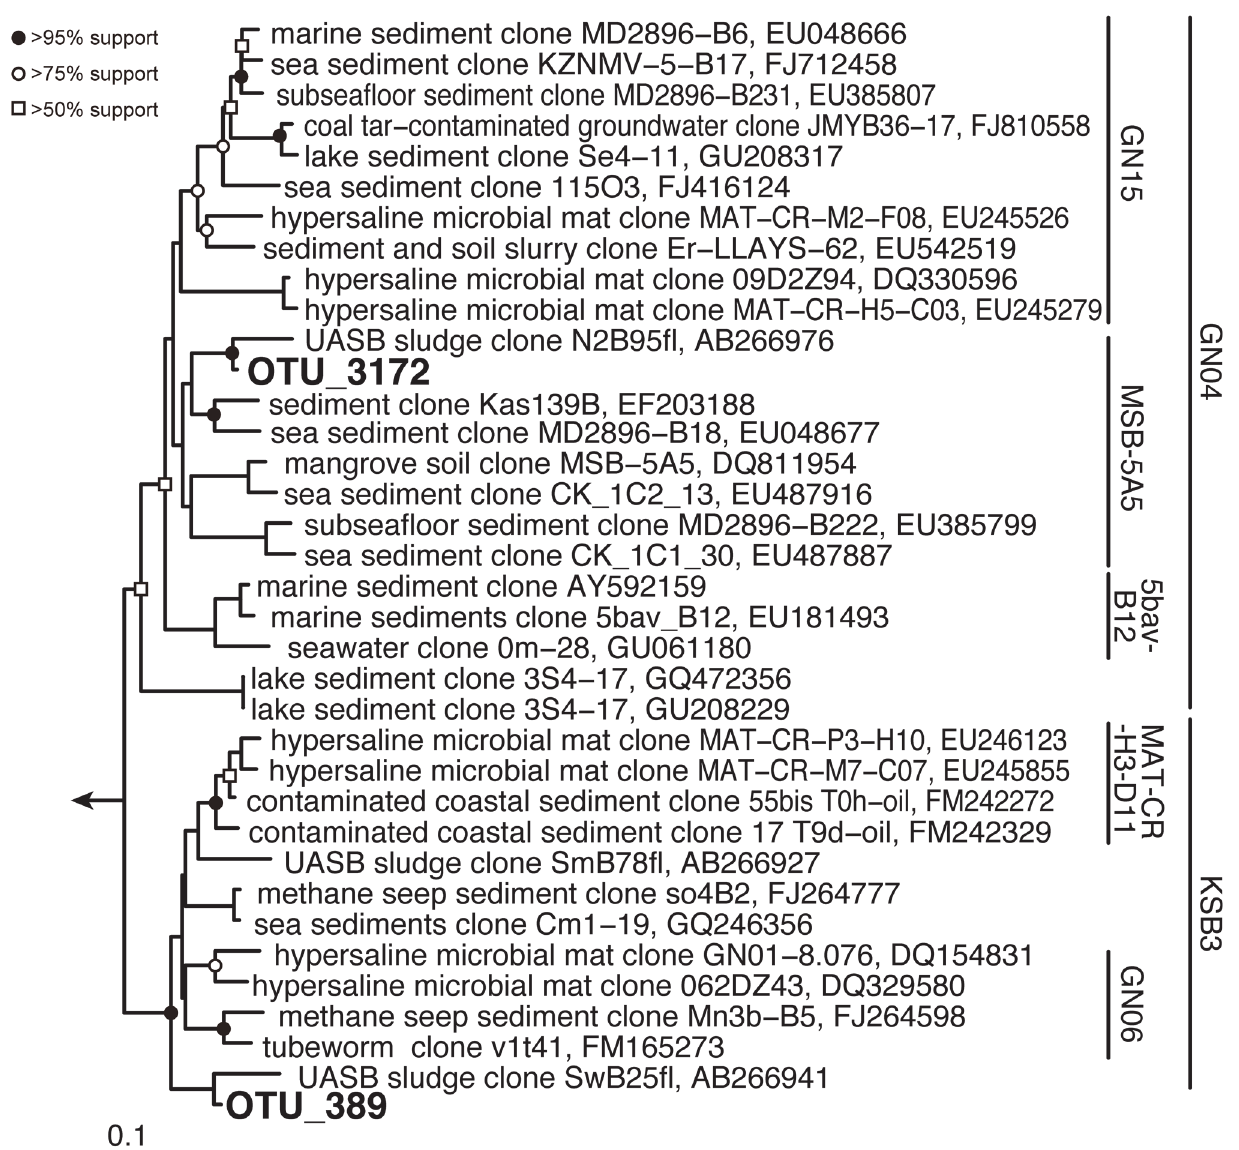
Fig 5. Distance matrix tree of 16S rRNA gene sequences assigned to the candidate phyla GN04 and KSB3 retrieved from anaerobic reactors based on the neighbor-joining method. Boldface indicates the sequences obtained in this study. The 16S rRNA gene sequences of Methanosaeta harundinacea 8Ac (AY817738), Methanosaeta pelagica 03d30q (AB679167), Methanosaeta concilii opfikon (X51423) were used as outgroup. The bar indicates 10% base substitution. Branching points supported probabilities > 95%, > 75%, and > 50% by bootstrap analyses (based on 1,000 replicates) are indicated by solid circle, open circles, and open square,